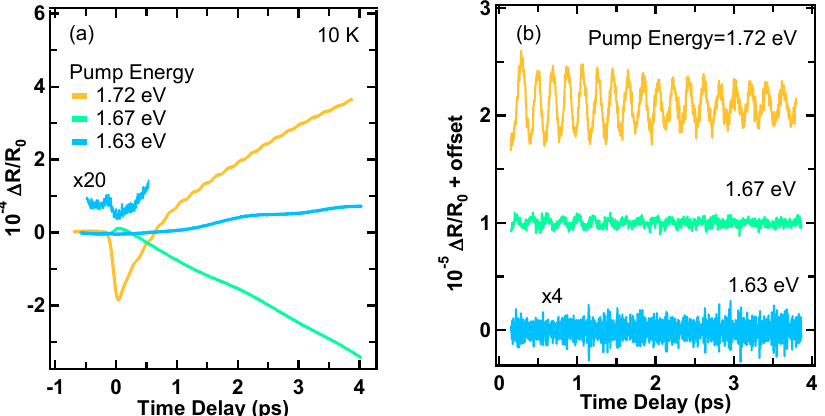
Figure 5. ( a ) ∆ R / R 0 signals in the YMnO 3 thin film at different pump photon energies at the pump power of 20 mW at 10 K. ( b ) Time-domain oscillatory signals with the subtraction of the fast and slow components.